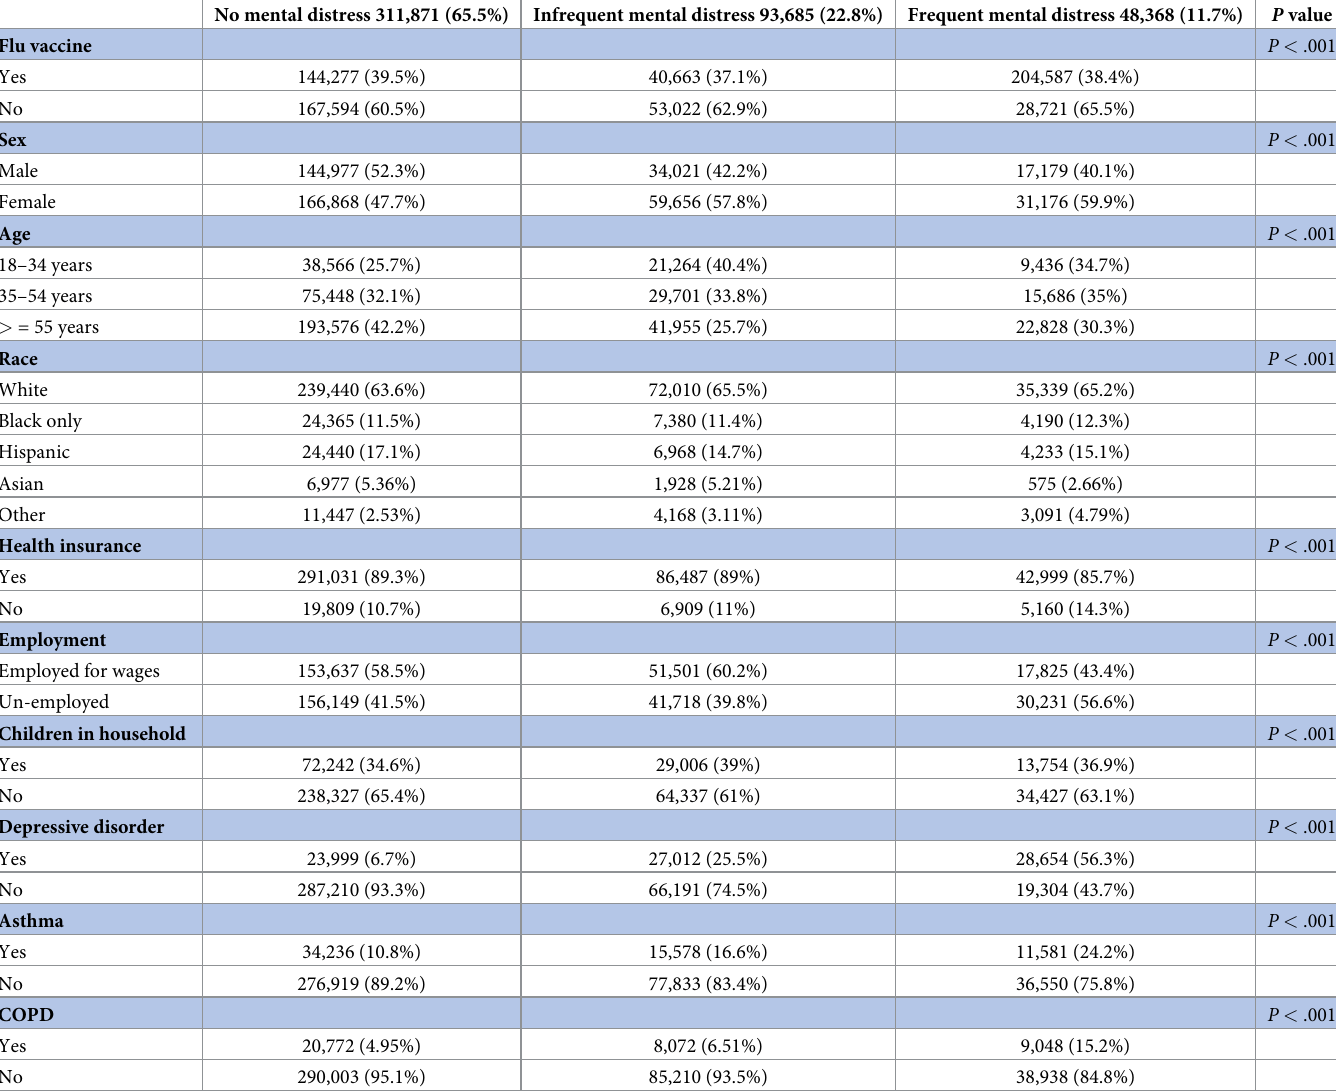
Table 1. Characteristics of US adults categorized into status of mental health, BRFSS